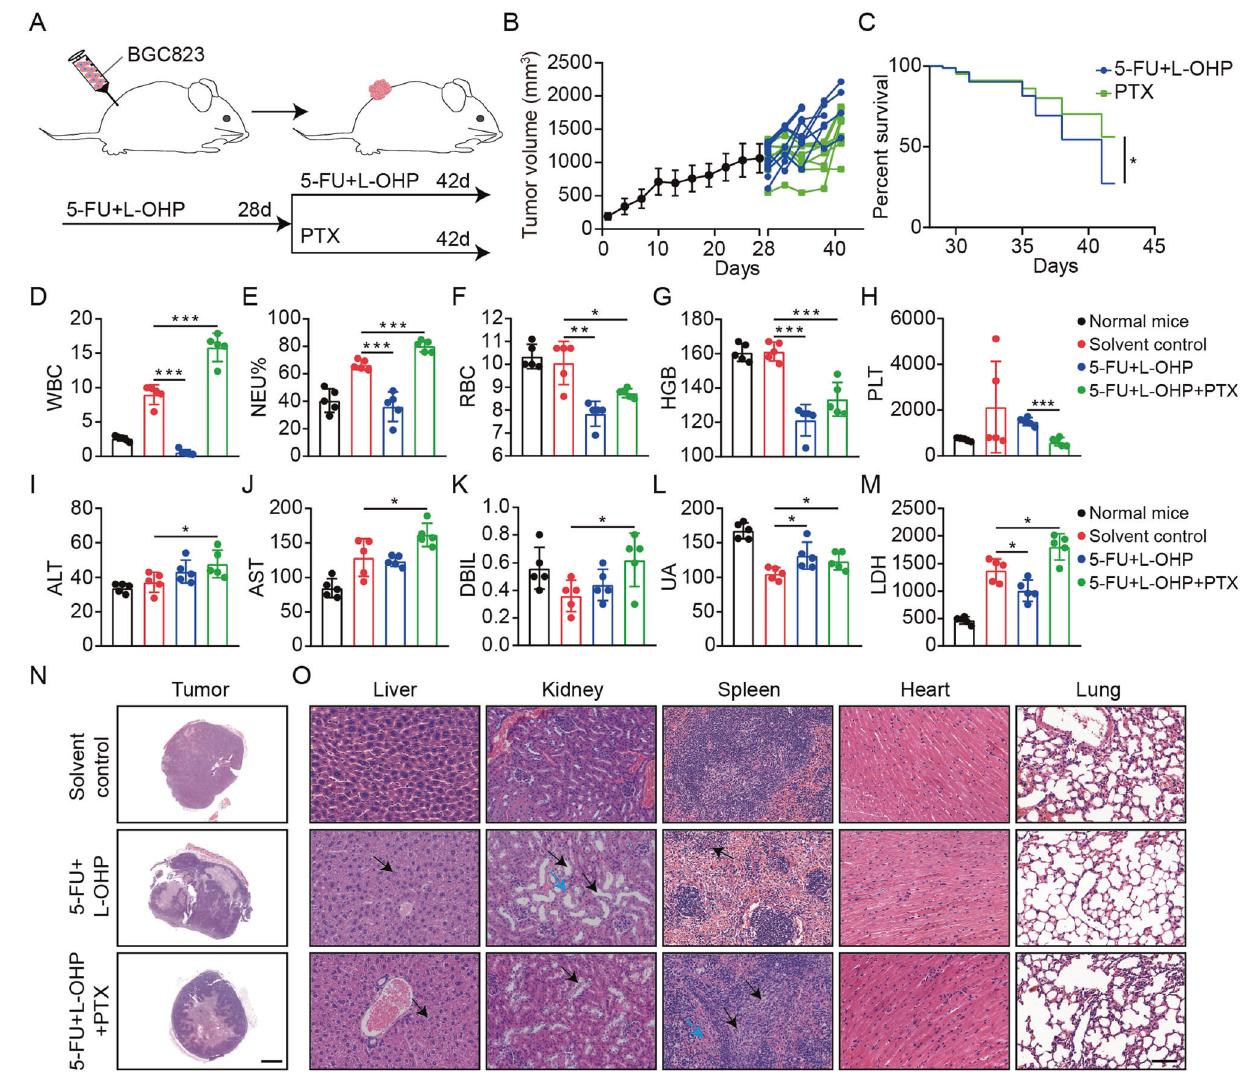
Fig. 2 Second-line chemotherapy reverses resistance to fi rst-line chemotherapy of GC. A Schematic representation of the BGC823-bearing model of sequential chemotherapy resistance. B The growth curves of tumor ( n = 12 per group). C Kaplan – Meier survival curve after 5-Fu plus oxaliplatin or paclitaxel treatments. * P < 0.05. D – H Blood routine index (WBC, NEU%, RBC, HGB, and PLT) were measured. Data are mean ± standard deviation. * P < 0.05, ** P < 0.01, *** P < 0.001. I – M Blood biochemical index (ALT, AST, DBIL, UA, and LDH) were measured. Data are mean ± standard deviation. * P < 0.05. N , O The representative images of tumor, liver, kidney, spleen, heart and lung by H&E staining. N Scale bars, 2000 μ m, O Scale bars, 50 μ